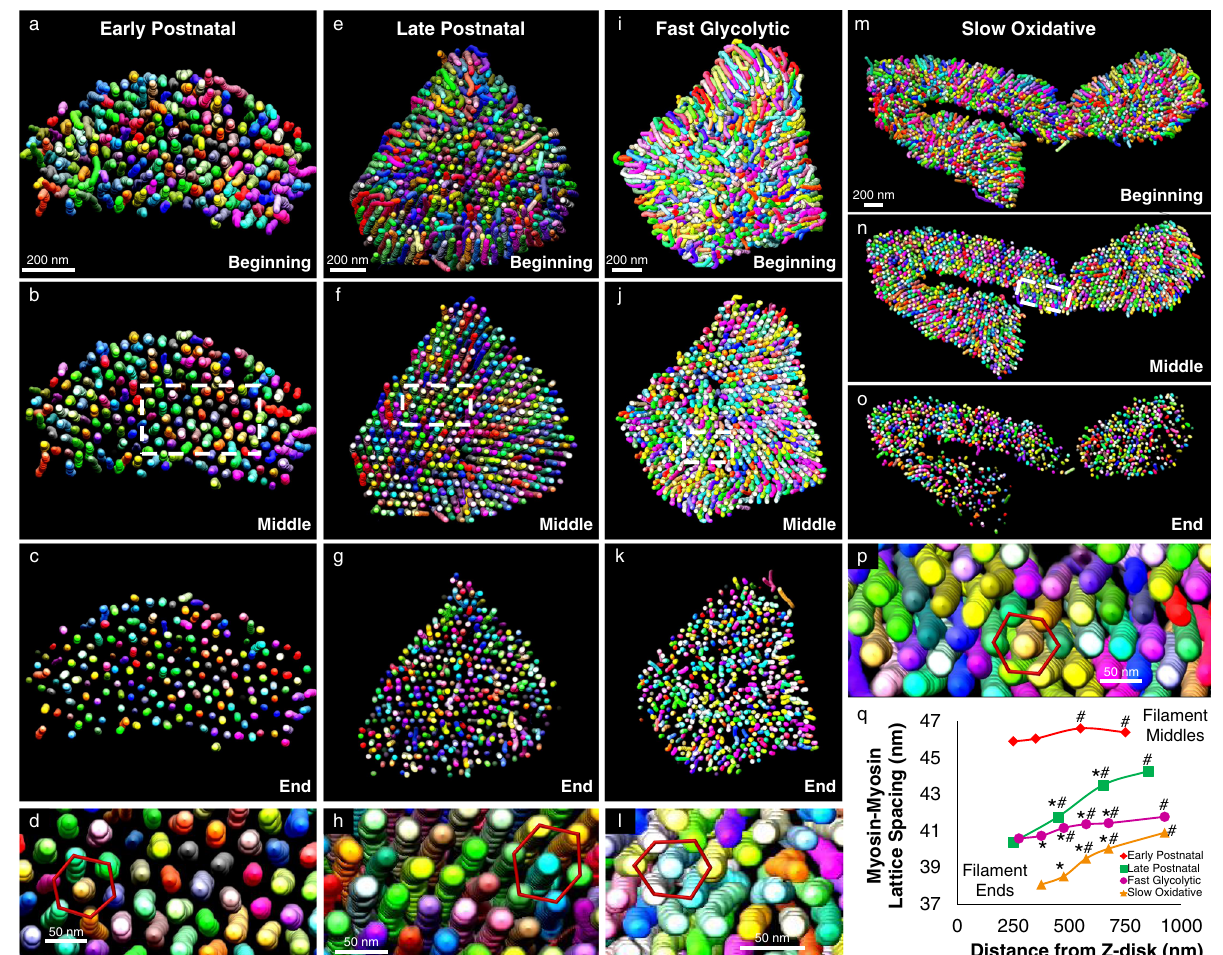
Fig.4|Myosinlatticespacingintrasarcomereheterogeneity.a – p 3Drenderings of myosin fi laments (various colors) within representative single sarcomeres from Early Postnatal( a – d ),Late Postnatal ( e – h ),Fast Glycolytic( i – l ),and Slow Oxidative ( m – p ) muscles showing the entire sarcomere ( a , e , i , m ), half the sarcomere ( b , f , j , n ), the ends of the sarcomere ( c , g , k , o ),and the hexagonal fi lament lattice from the middle of the sarcomere ( d, h , l , p ). q Myosin-myosin lattice spacing as a function of distance from the Z-disk for Early Postnatal (means shown as dia- monds), Late Postnatal (squares), Fast Glycolytic (circles), and Slow Oxidative